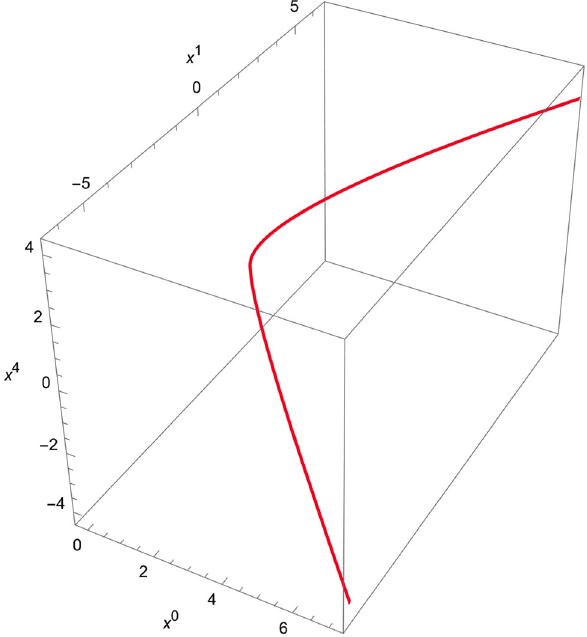
Fig. 2 Null geodesic motion obtained by means of Eqs. (2) and (19). The following values have been chosen: R = 1, θ = π/ 2, and ϕ =